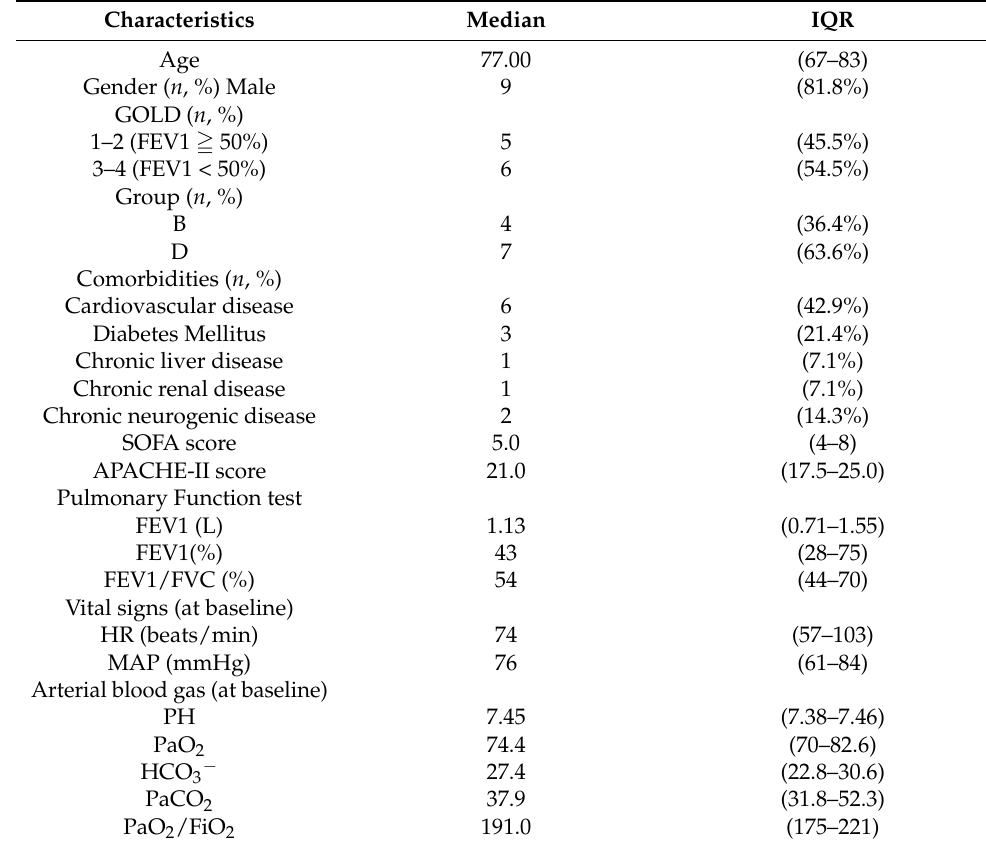
Table 1. Patient characteristics.